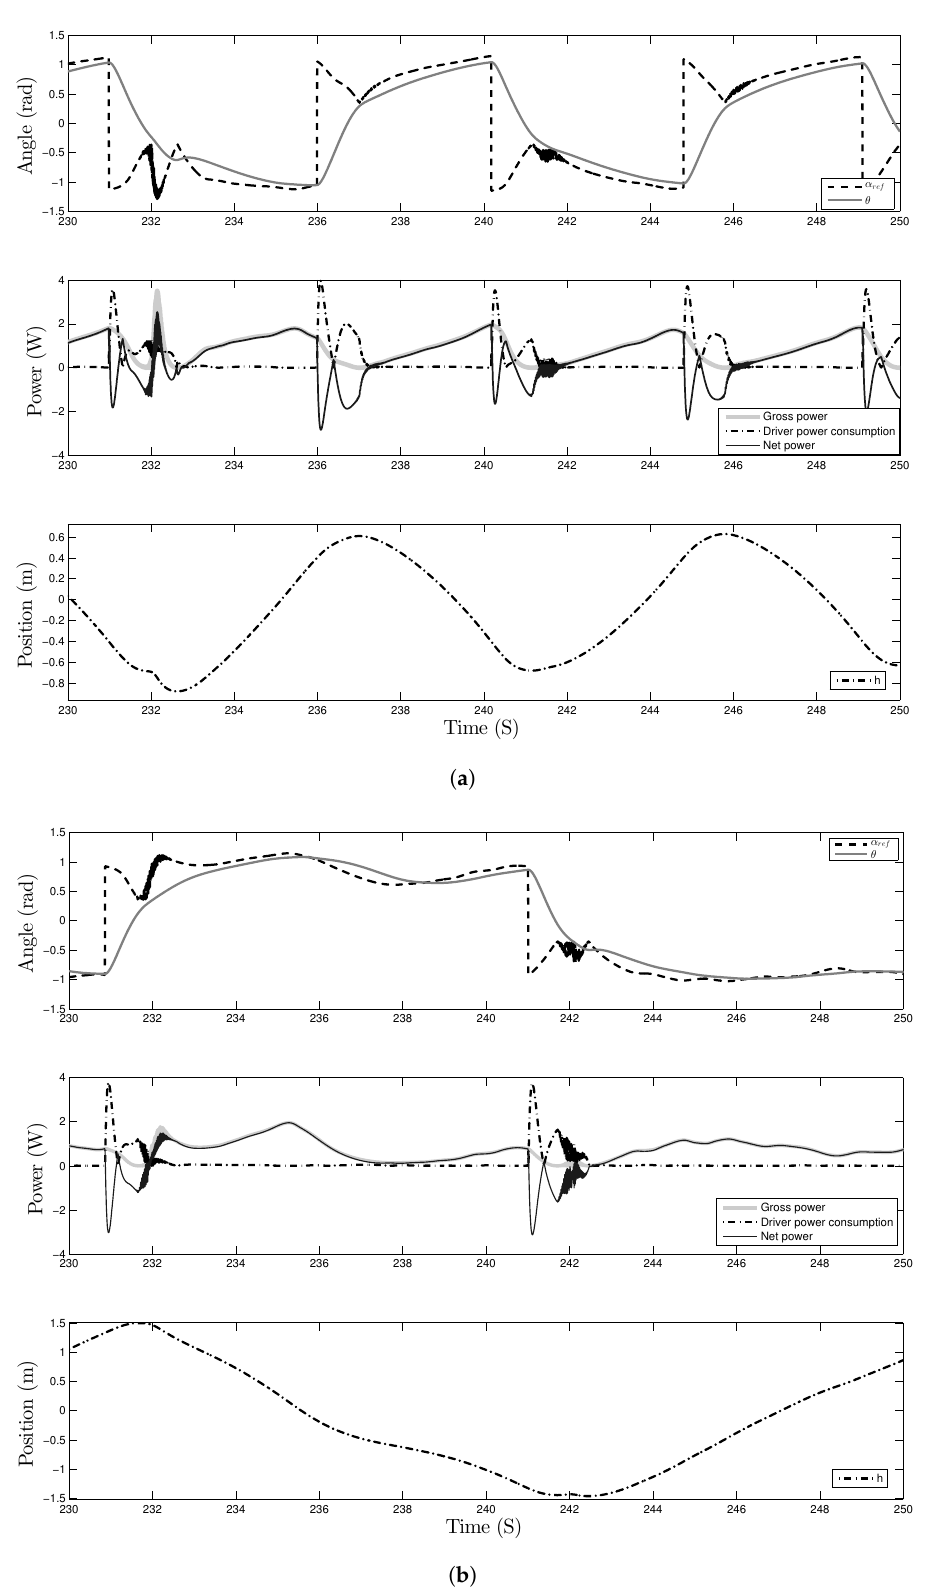
Figure A1. System response for different h 0 / c . ( a ) h 0 / c = 1.25, ( b ) h 0 / c = 3.25, as in Figure